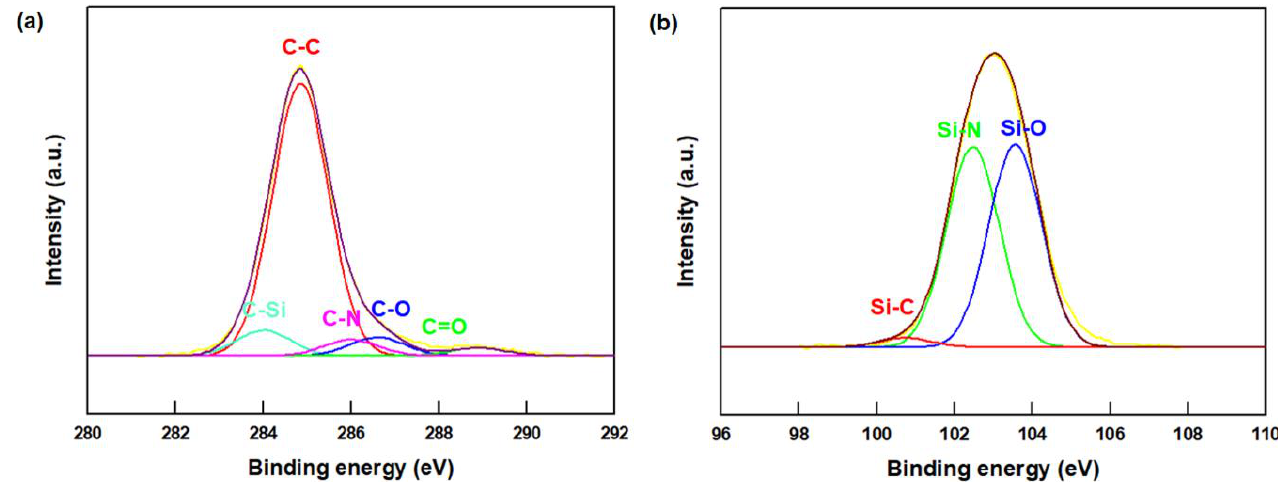
Figure 2. XPS analysis of the surface-modified aggregated boron nitride (ABN): ( a ) C 1s, ( b ) Si 2p deconvolution.